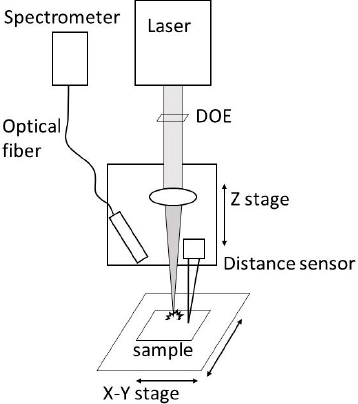
Figure 1. Experimental setup for laser-induced breakdown spectroscopy (LIBS).